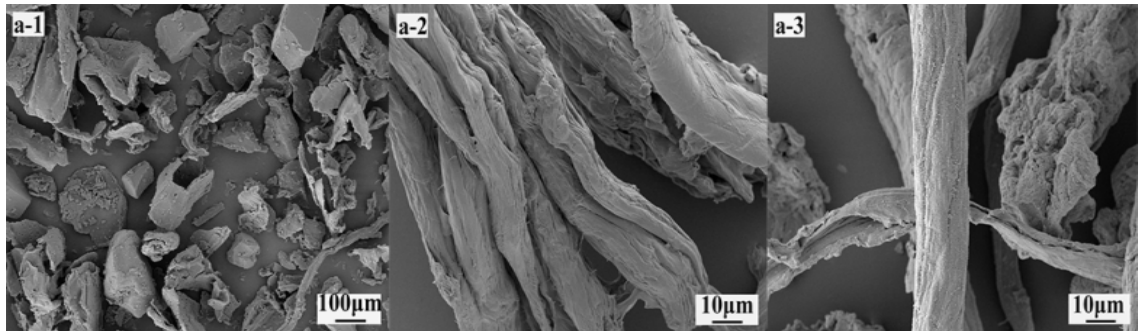
Figure 2. ( a-1 ) SEM images showing microstructure differences for unprocessed eucalyptus bark ( a-2 ), cellulose microfibrils after chemical treatment, and ( a-3 ) CMC produced from the eucalyptus bark cellulose.